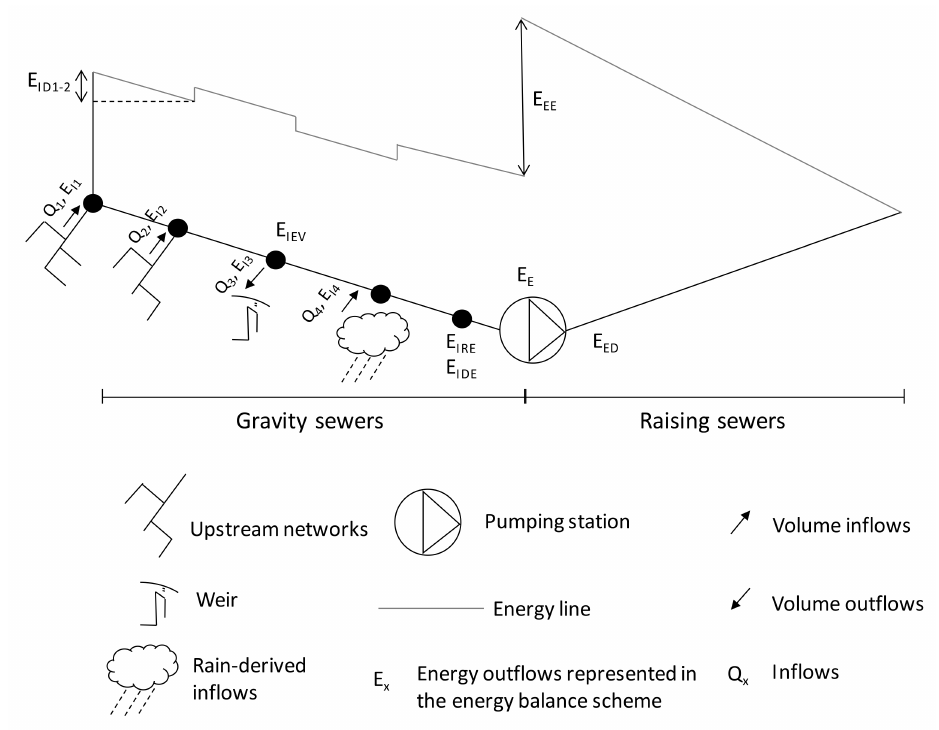
Figure 1. Schematic representation of the energy components in wastewater